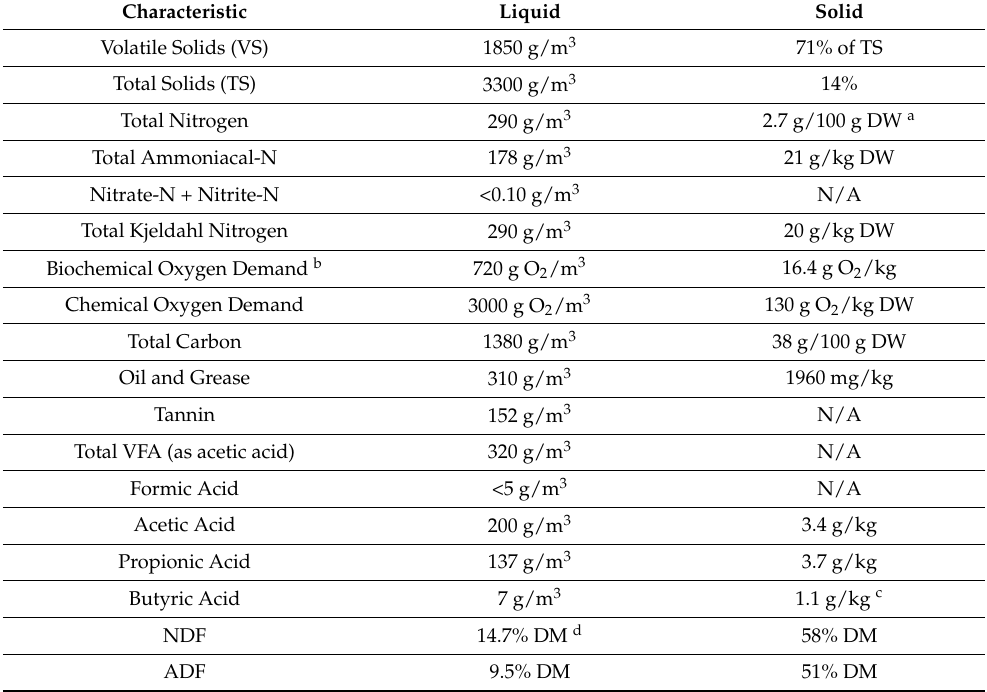
Table 6. Characterization of liquid and solid